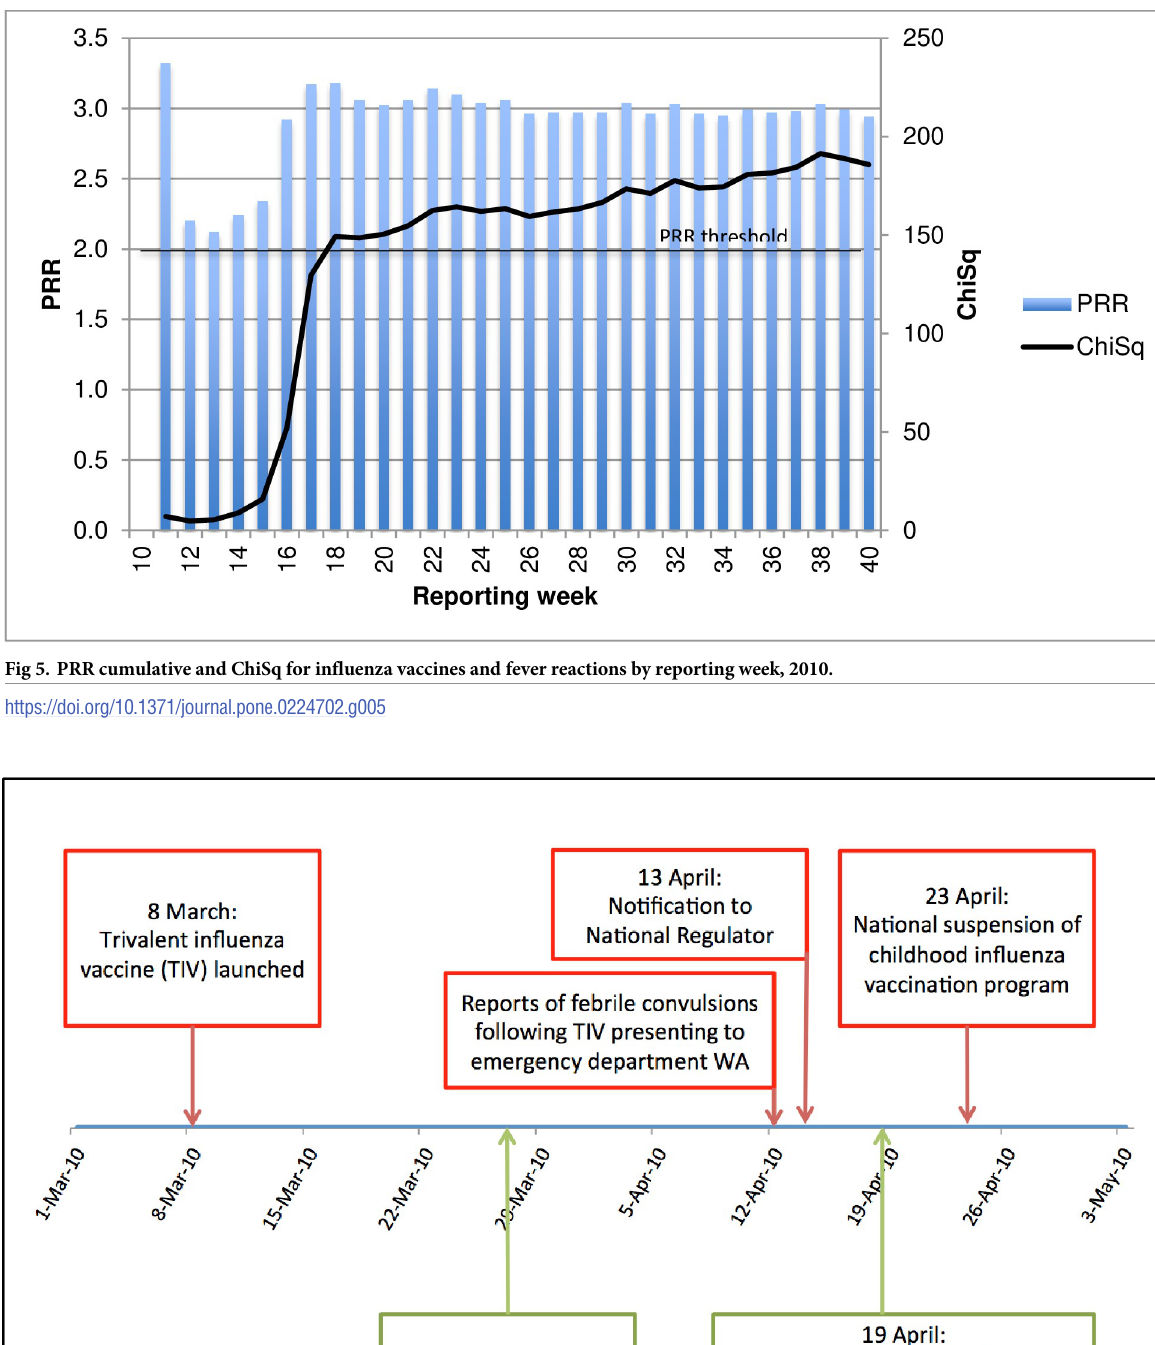
PLOS ONE | https://doi.org/10.1371/journal.pone.0224702 November1,